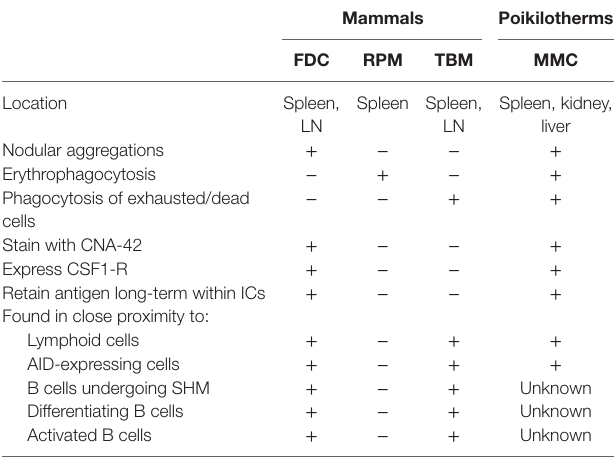
TABLe 1 | Comparison of poikilotherm melanomacrophages with mammalian follicular dendritic cells (FDC), red pulp macrophages (RPM), and tingible body macrophages